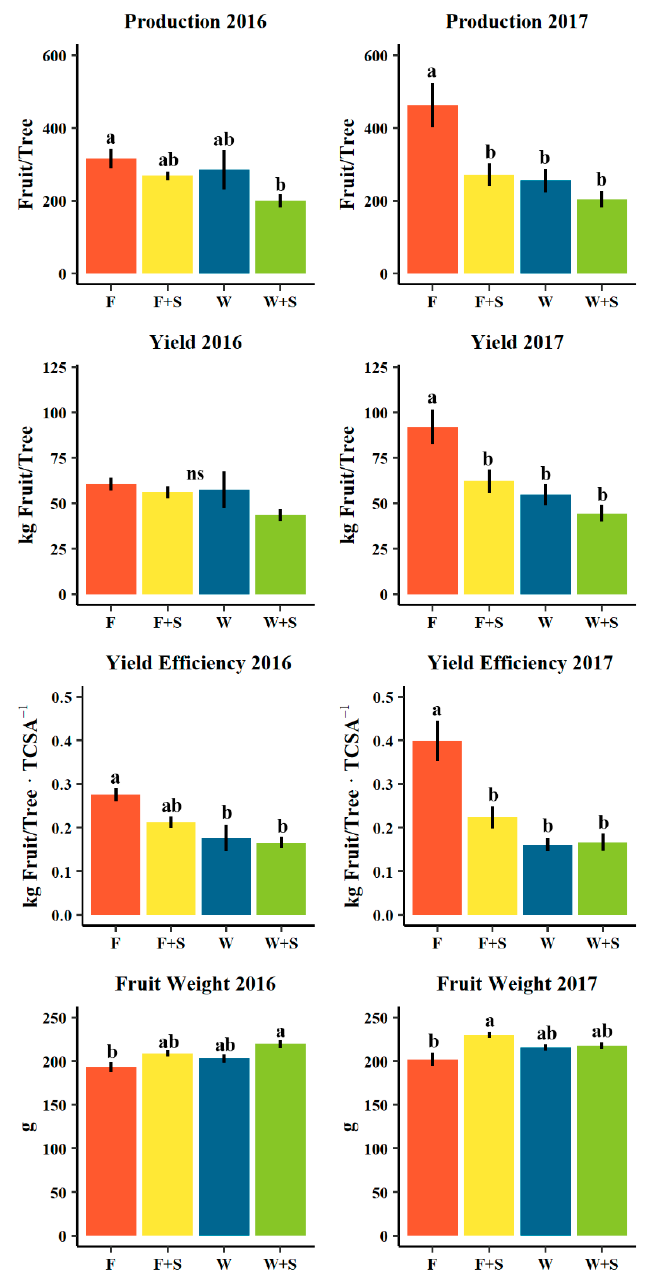
Figure 3. Mean production (number fruit/tree), yield (kg/tree), yield efficiency (kg fruit/tree ∙ TCSA[cm 2 ] − 1 ), and average fruit weight (g) in 2016 (left) and 2017 (right) among seasonal pruning treatments consisting of fall pruning (F, orange), fall and summer pruning (F+S, yellow), winter pruning (W, blue), and winter and summer pruning (W+S, green). Error bars indicate ± standard error. Different letters indicate significance difference among means ( p < 0.05, Tukey HSD). “ns” indicates no significant difference among means ( p > 0.05, Tukey HSD).